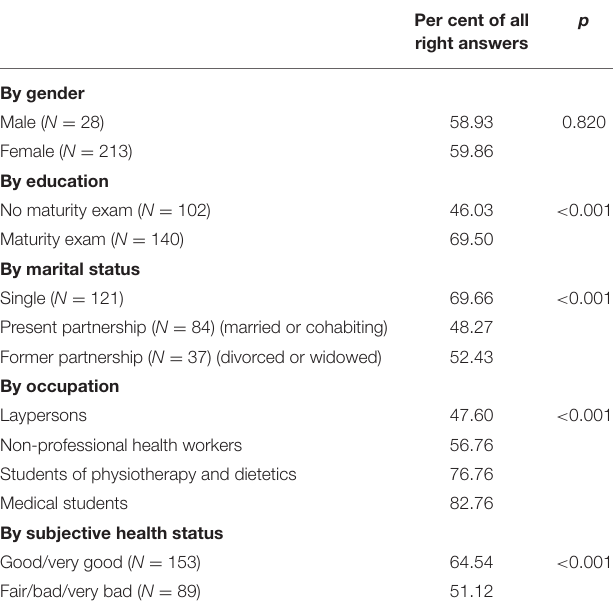
TABLE 5 | Comparison of readability scores of the assessed health literacy Per cent of all right answers